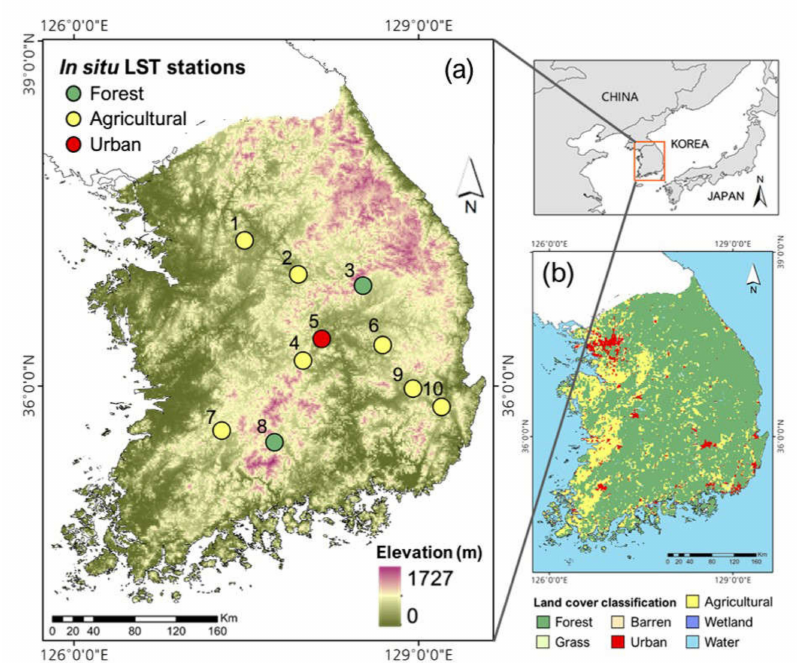
Figure 1. ( a ) Study area and in situ reference data locations with 1 km elevation derived from Shuttle Radar Topography Mission (SRTM) digital elevation model (DEM), and ( b ) The landcover provided by Ministry of Environment of South Korea (http: //